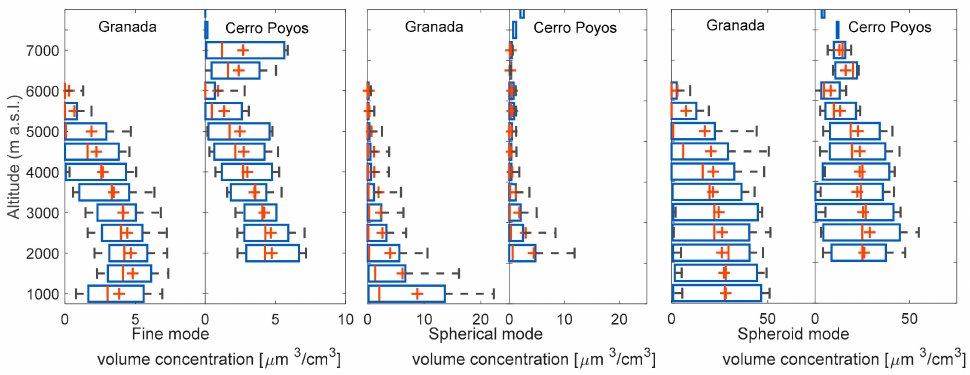
Figure 2. Box-and-whisker plots of the volume concentration of every mode in layers of 500 m. The red cross indicates the mean value, and the central line in the box is the median. The extremes of the box correspond to the first and third quartile, and the bars indicate the standard